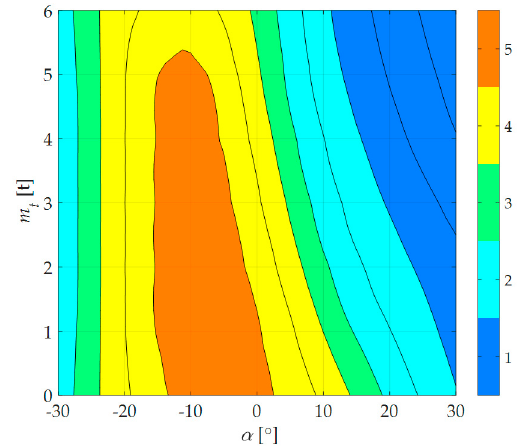
Figure 10. Gear depending on mass and slope.